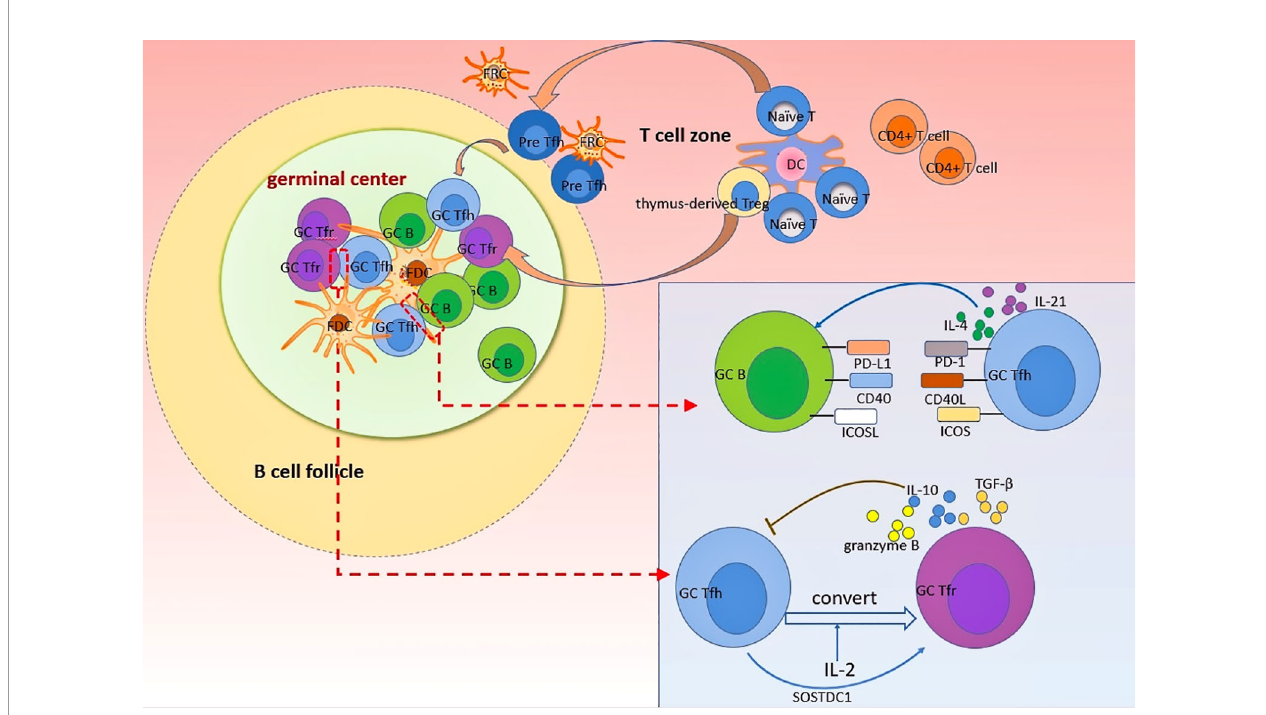
FIGURE 1 | Dynamics of Tfh and Tfr cells in GC response. Naïve T cells and thymus-derived Treg can differentiate into Tfr and Tfh cells, respectively, after the priming by dendritic cells. Differentiated Tfr and Tfh cells gradually migrate into follicles in a CXCR5-dependant manner to exert profound impacts on GC B cells. Follicular stromal cells such as FDC provide an important plat form for various cellular interaction. In GC, Tfh cells support B cells differentiation and antibodies production by providing essential signals to B cells through direct interactions mediated by PD-1, CD40L, and ICOS, as wells as cytokines such as IL-4 and IL-21. By contrast, Tfr cells uniquely inhibit the differentiation and function of Tfh cells through secreting several anti-in fl ammatory cytokines (including IL-10, TGF- b , granzyme B) to suppress the GC response. The crosstalk between Tfr and Tfh cells is complex. Tfh cells can convert into Tfr cells after stimulation by IL-2. Moreover, SOSTDC1-producing Tfh cells can serve as an inducer of Tfr